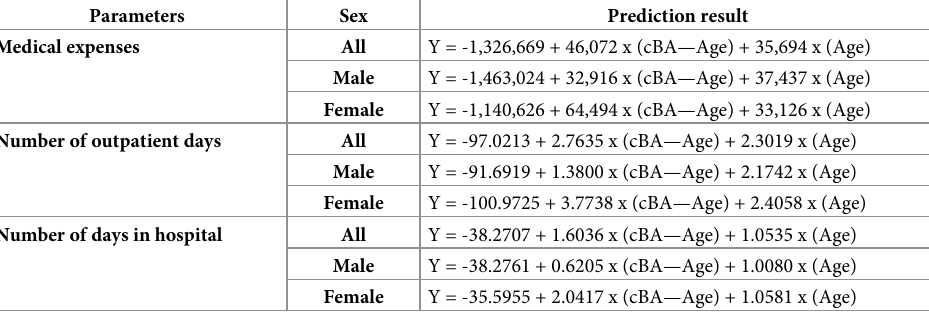
Table 4. Prediction results of annual medical expenses and medical care use depending on the differences between cBA and